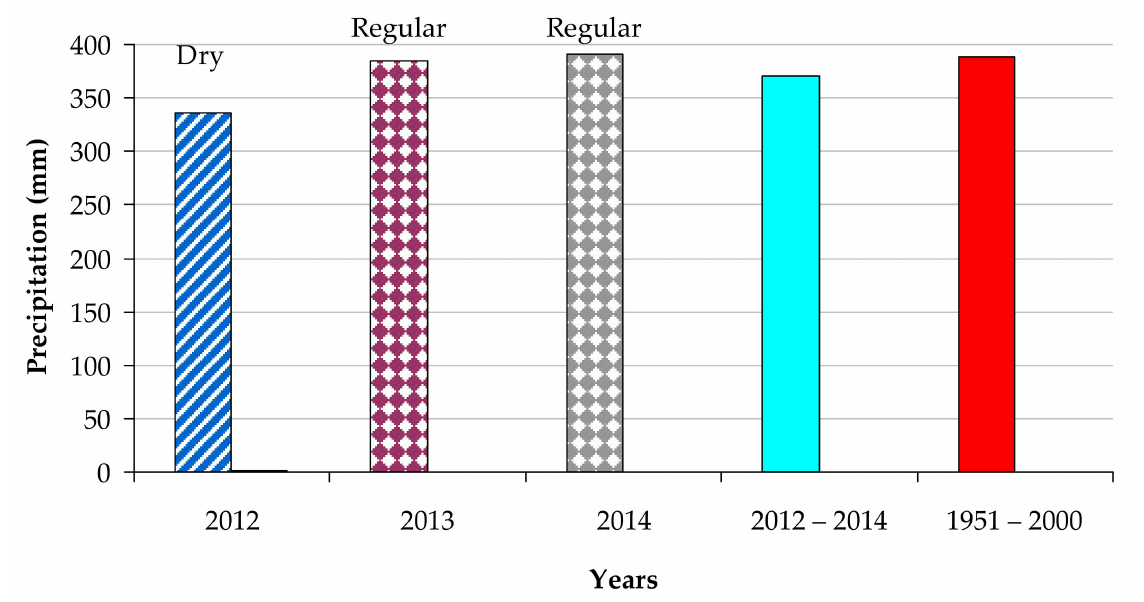
Figure 3. The sum of precipitation (mm) in the April–August period in the years of study 2012–2014 compared to the multiyear (1951–2000). Descriptors dry and regular correspond to April–August periods of the 1951–2000